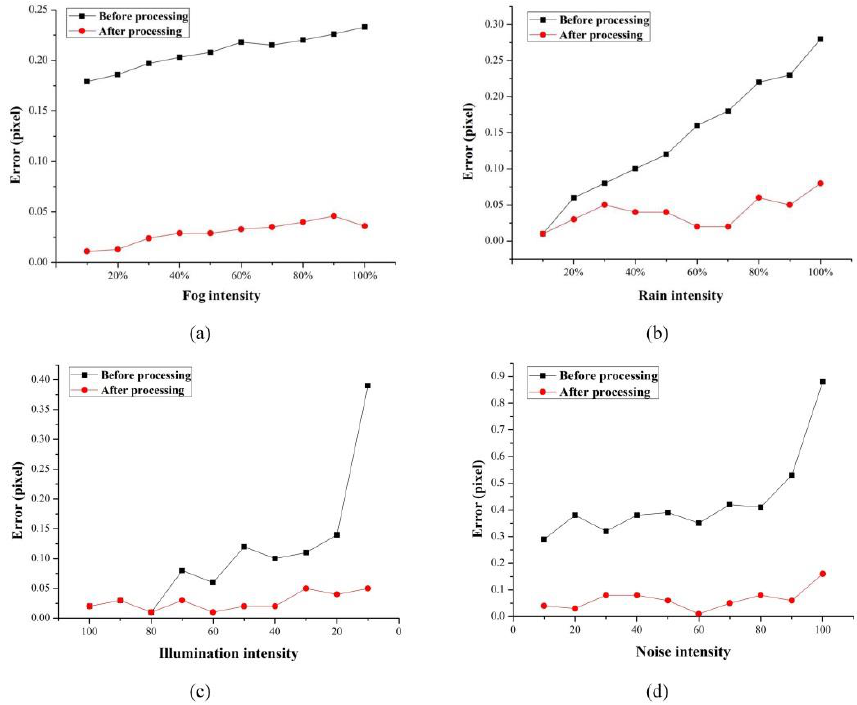
Figure 10. Target center positioning errors under single environment parameter interference before and after processing: ( a ) fog; ( b ) rain; ( c ) low illumination; ( d )